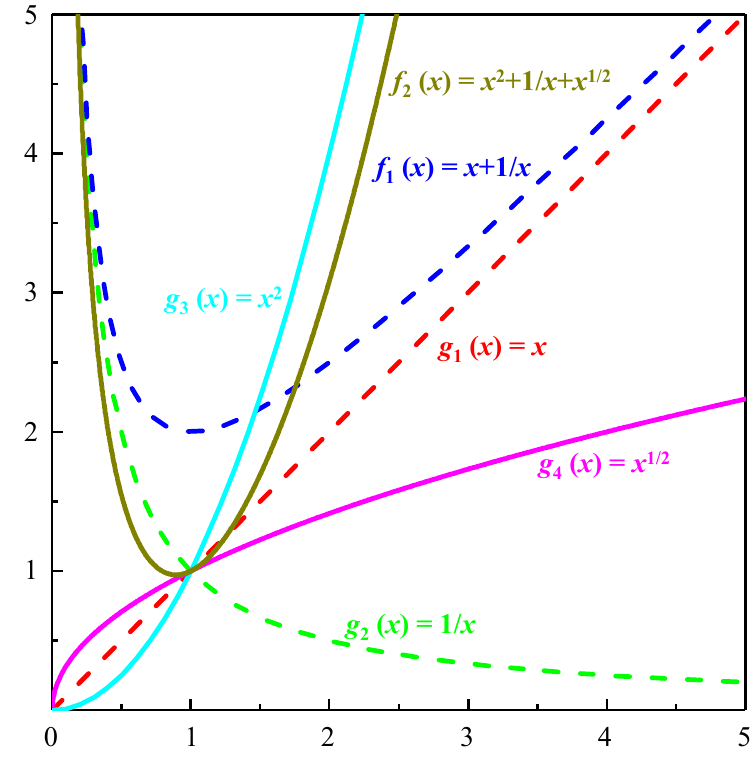
Figure 12. Fitting formula determination.